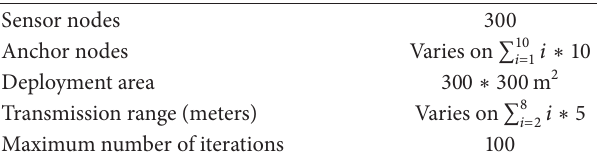
Table 1: Parameter setting for WSN.